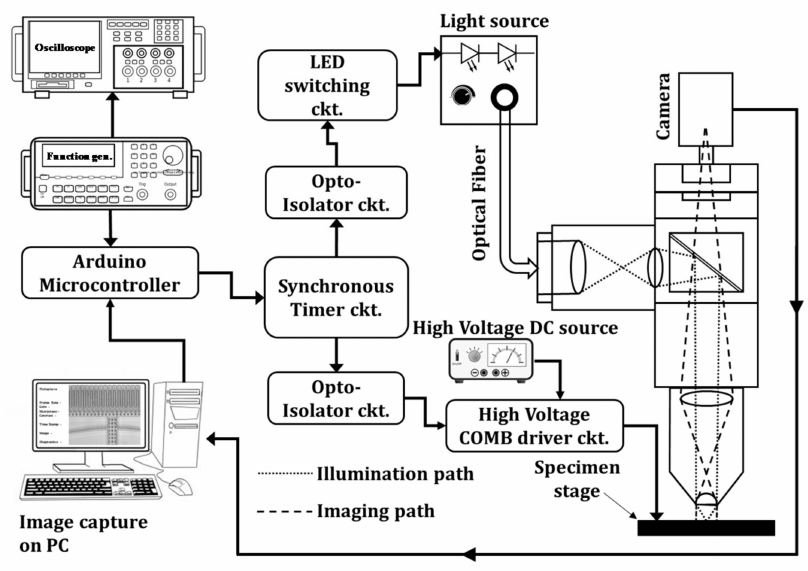
Figure 1. Block diagram of stroboscopic imaging